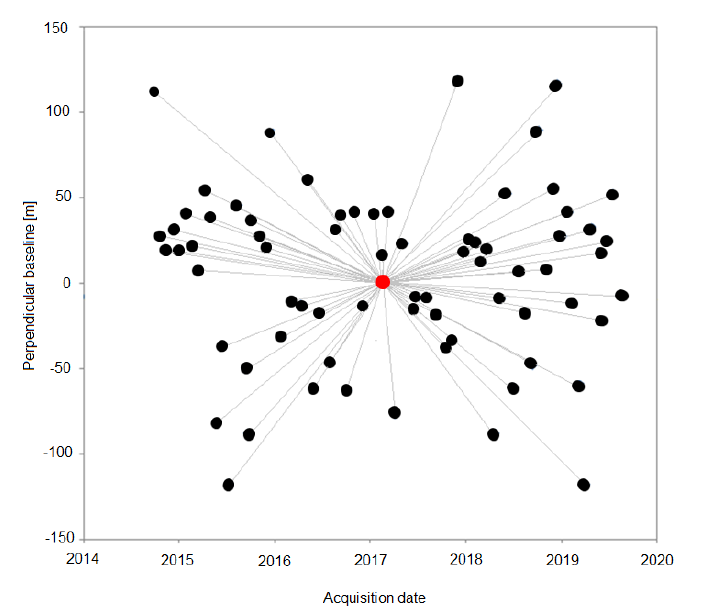
Figure 2. Spatio-temporal relation-baseline plot; master image (red dot) and slave images (black